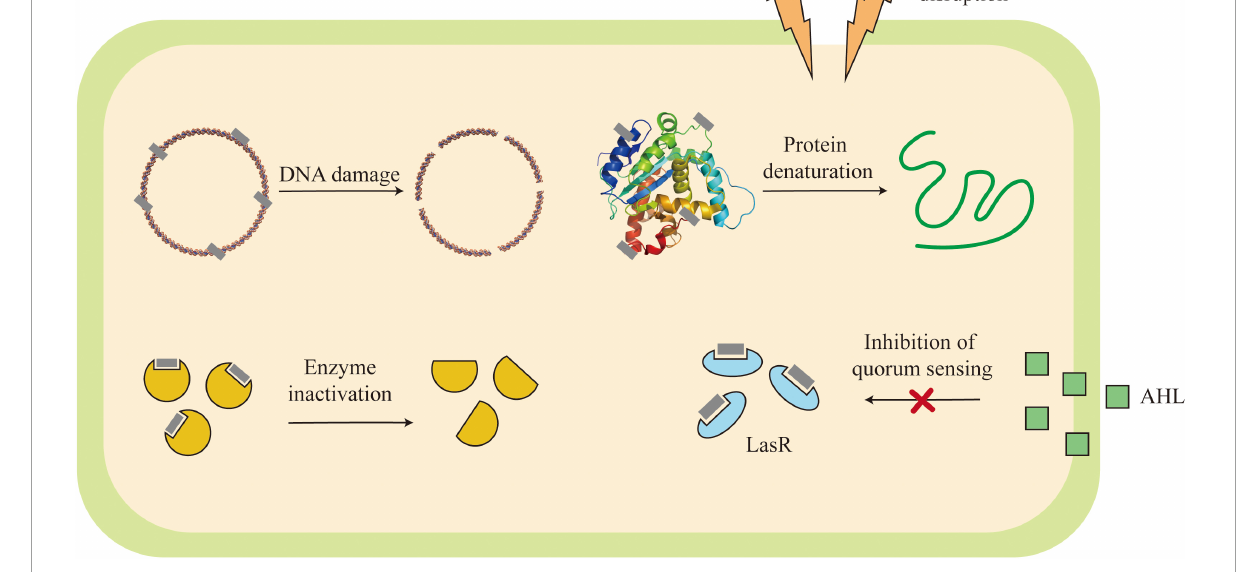
FIGURE6 Mechanism of action for antibacterial activity.